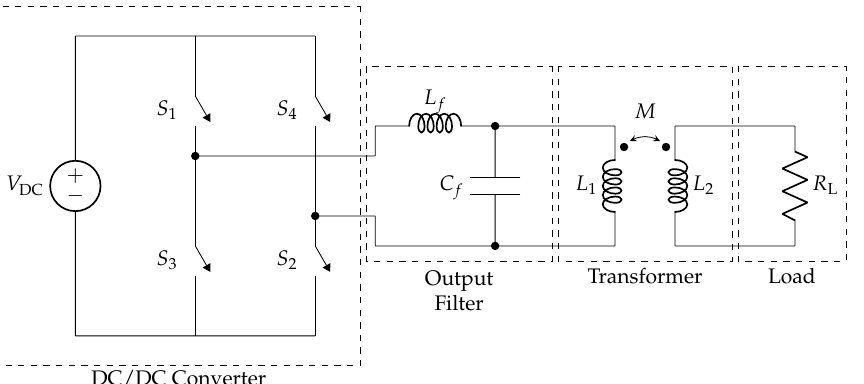
Figure 5. Equivalent circuit of the rotary transformer supplied by a full-bridge converter. For the sake of simplicity, no compensation is reported in this